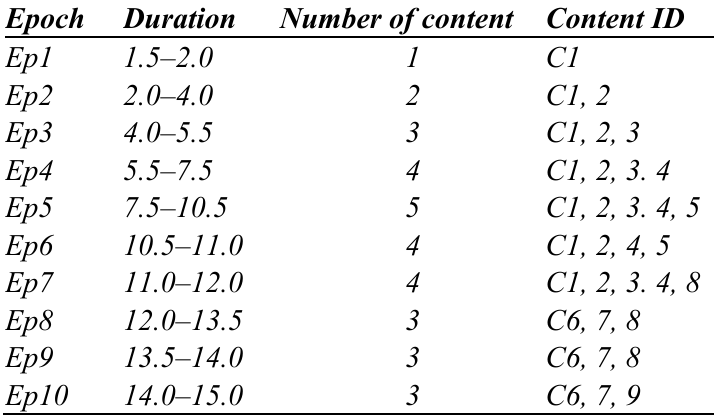
Figure 6. Synchronization of fusion